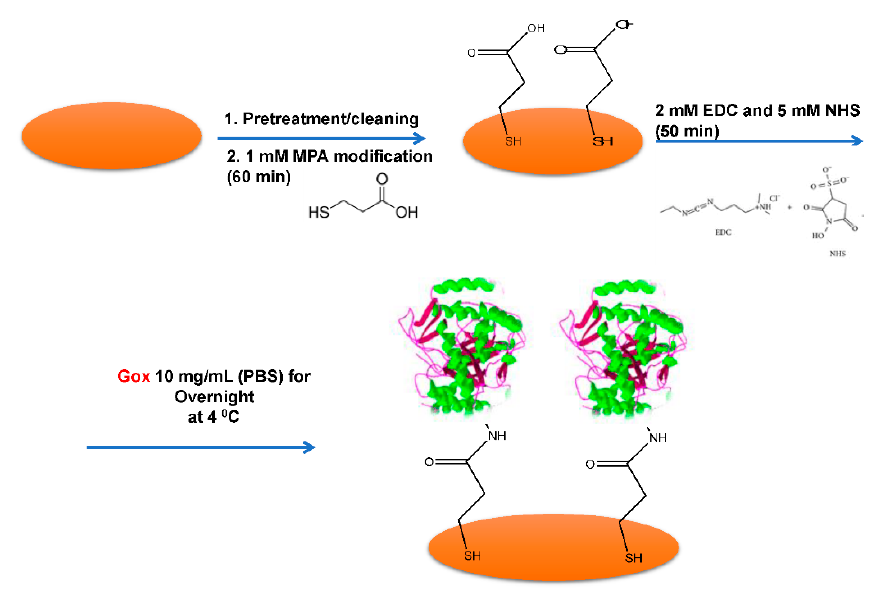
Scheme 1. Schematic illustration of the GOx immobilization on PCB surface.